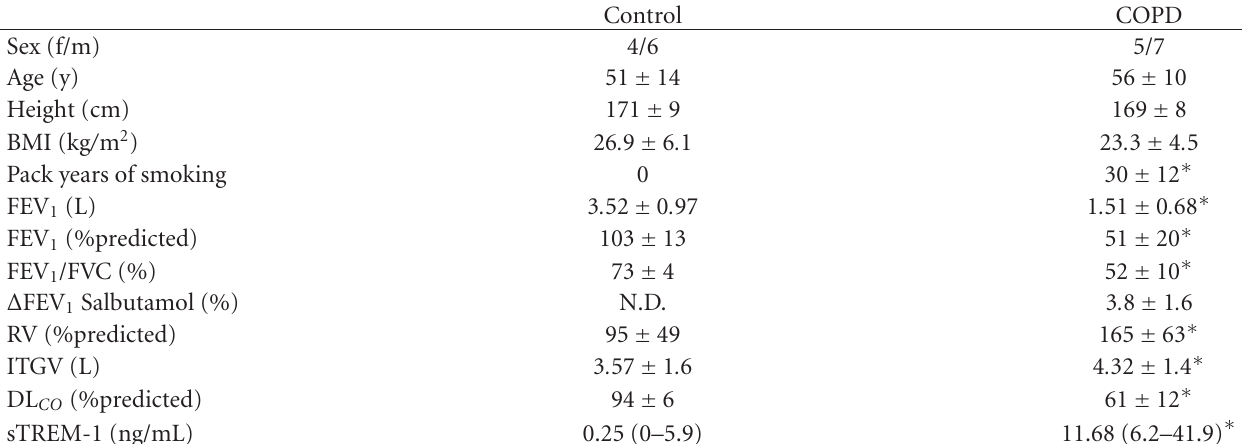
Table 1: Patients’ characteristics (ND not